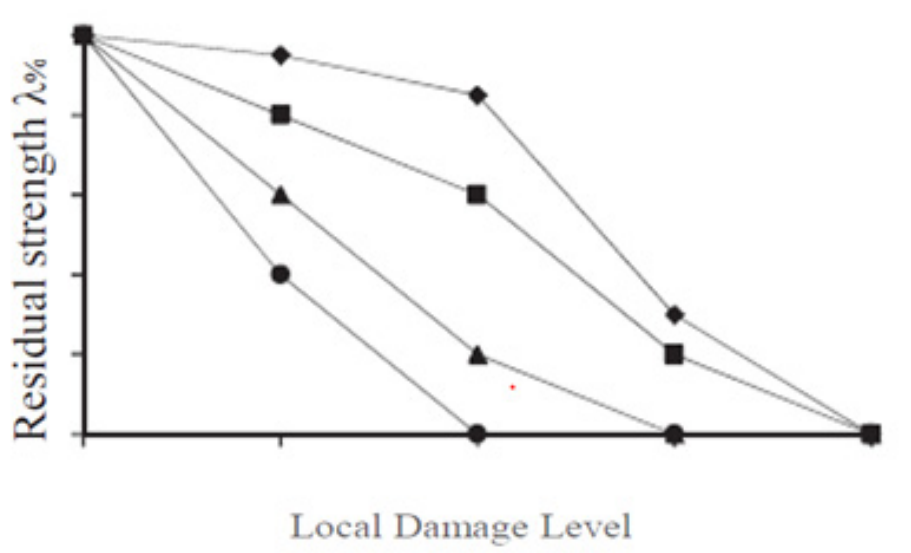
Figure 1. Typical robustness curves; different markers represent different locations for the presumed damage along the structure.